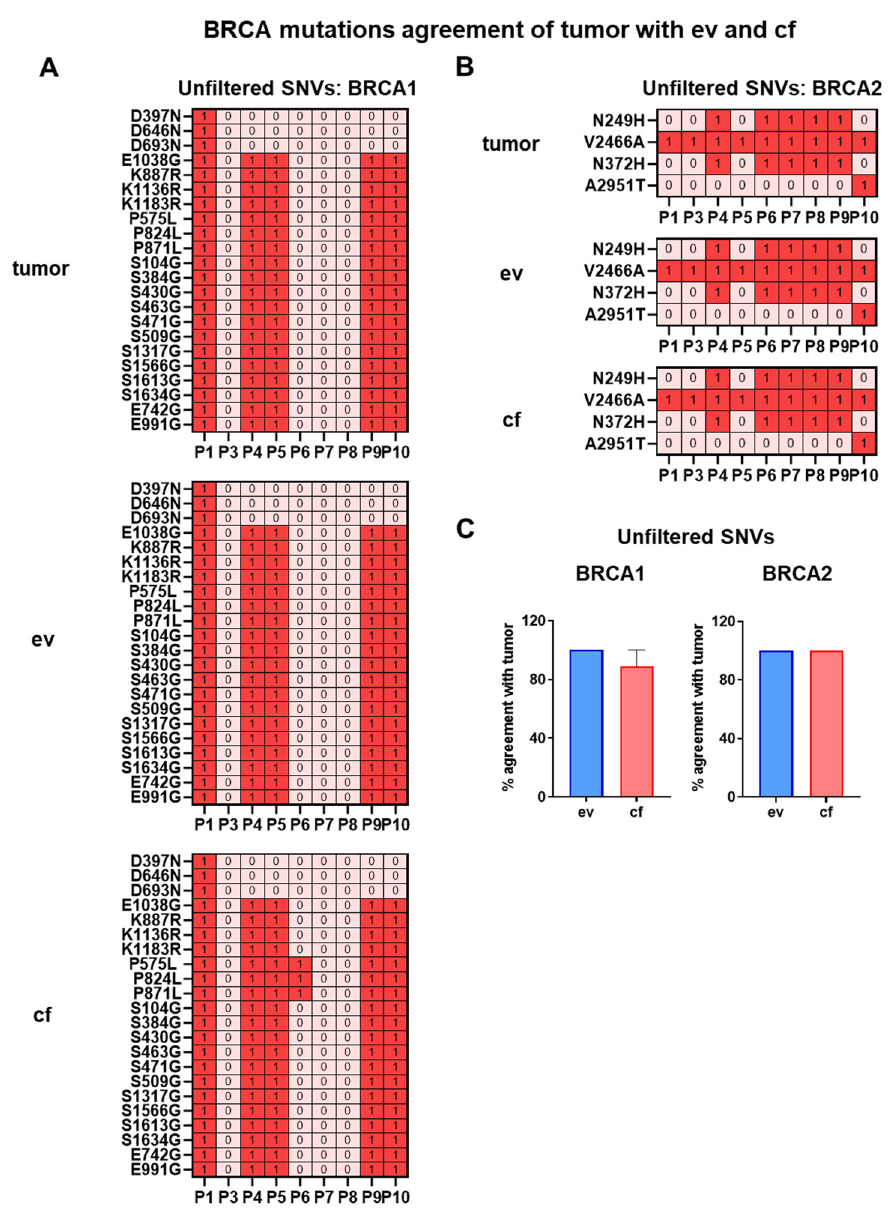
Figure 13. Heat maps of BRCA variant concordance between tumor-, ev- and cfDNA. ( A ) BRCA1 and ( B ) BRCA2 variants of unfiltered SNVs. ( C ) Percentage concordance of BRCA1 and BRCA2 variants between tumor-, ev- and cfDNA. Statistical tests: ( C ) Repeated-measures one-way analysis with Tukey multiple comparisons test.